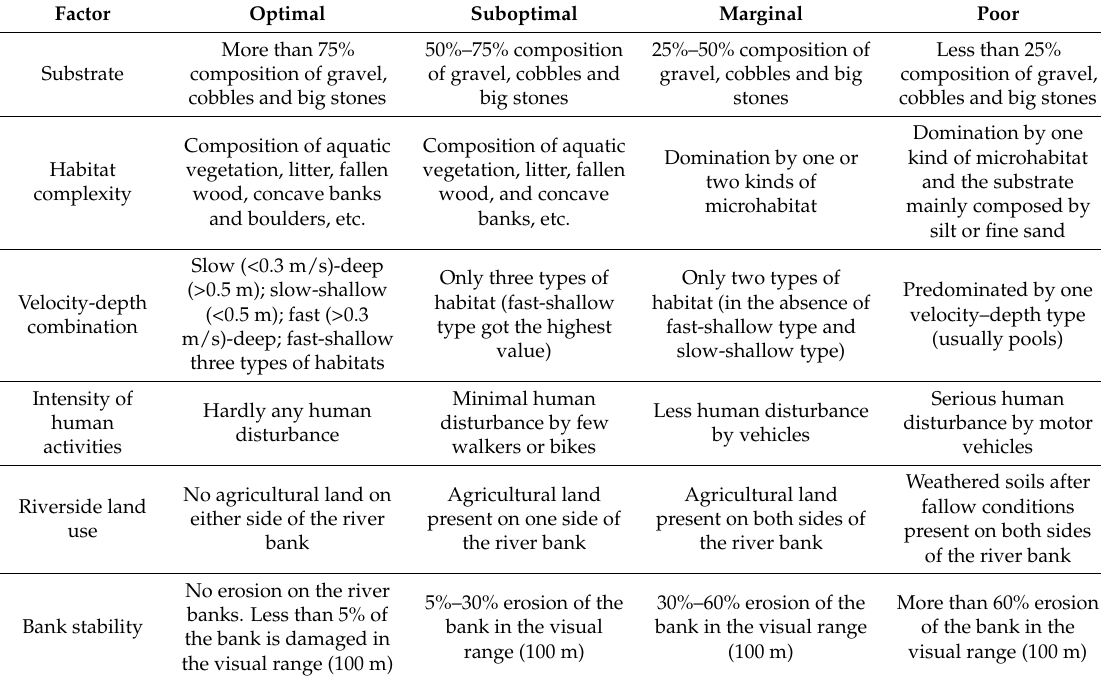
Table A1. Habitat assessment scoring